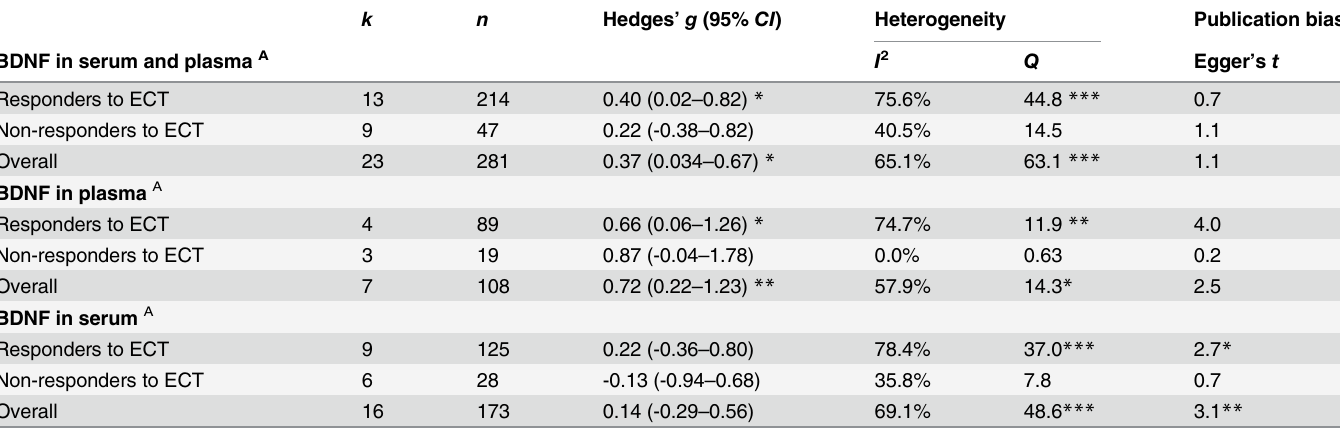
Table 5. Pooled effect-size estimates, heterogeneity and publication bias for the clinical studies by sub-group meta-analyses indicated in the row. k